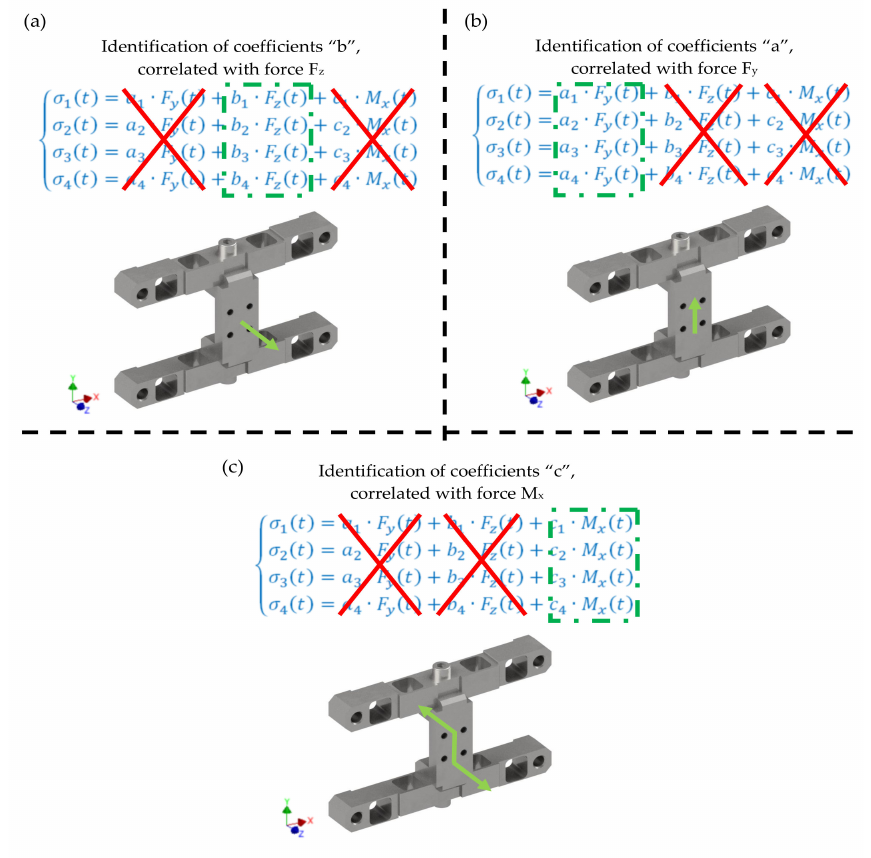
Figure 12. Transducer calibration concept.